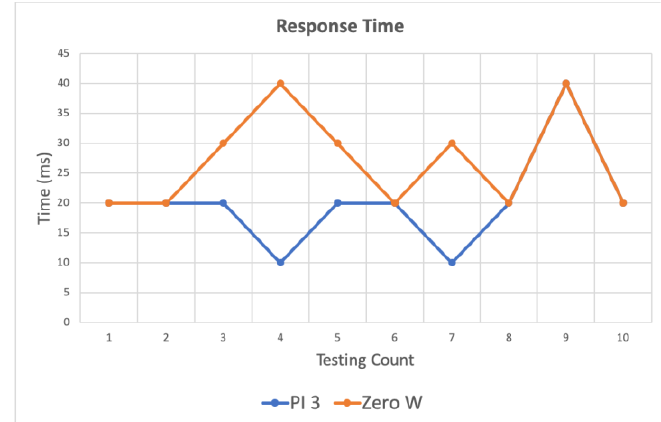
Figure 9. Response time of publish/subscribe for PI 3 and Zero W. The blue line shows that PI 3 is both a publisher and a subscriber. The orange line shows that Zero W is both a publisher and a subscriber.